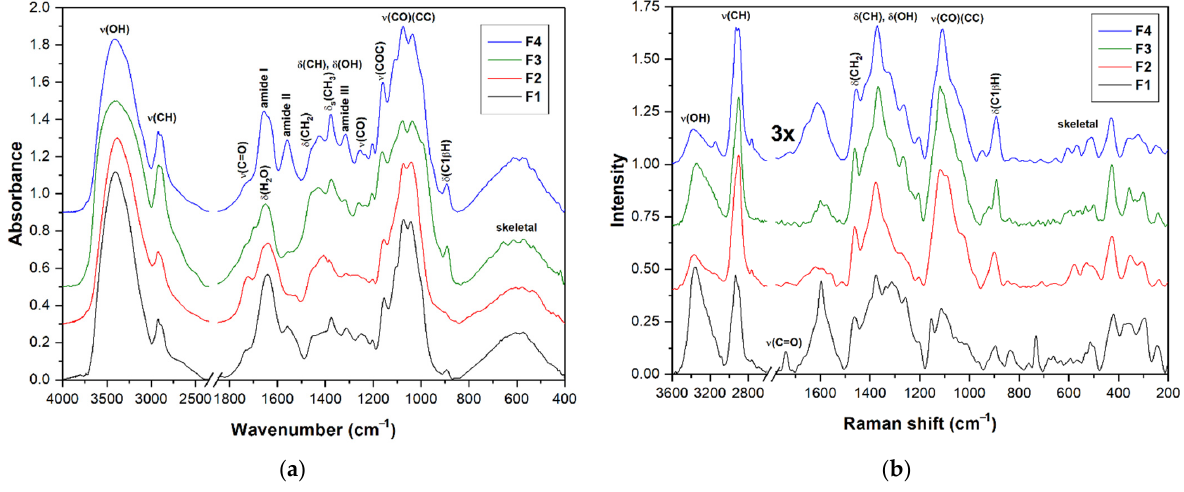
Figure 4. FTIR ( a ) and FT Raman ( b ) spectra of the fractions F1 , F2 , F3 , and F4 obtained from basidiocarp of G. resinaceum .